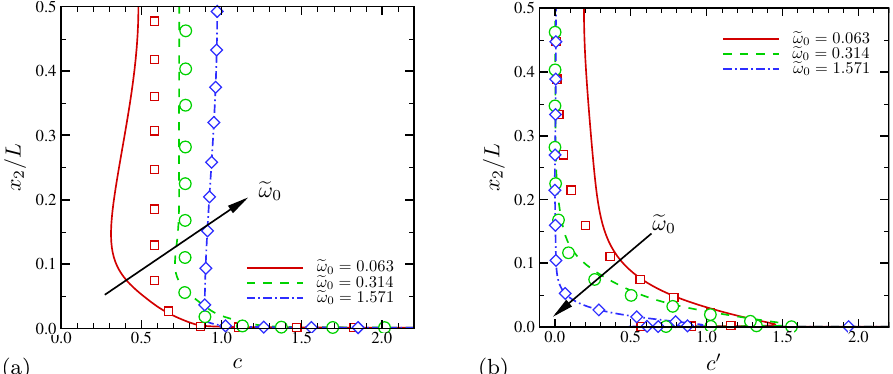
Figure 8. The wall-normal profiles of ( a ) time-averaged salt concentration and ( b ) salt fluctuation RMS. Symbols indicate the solutions from the corresponding 1D